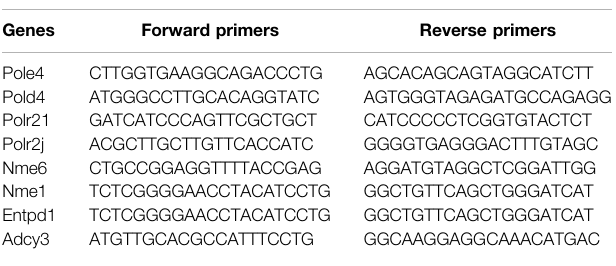
TABLE 1 | PCR primer sequences of hub